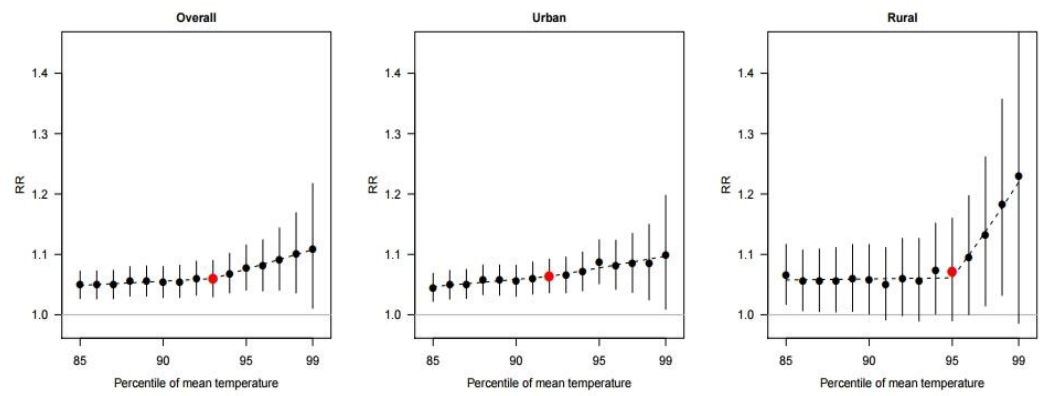
Figure 2. Associations between the percentile of the mean temperature and pooled heatwave-related mortality risk (RR) in the total, urban, and rural areas with 95% confidence interval (vertical lines). The dashed line indicates the relative risk based on the piecewise regression (a V-shape regression) model. The red points indicate the estimates at threshold points.